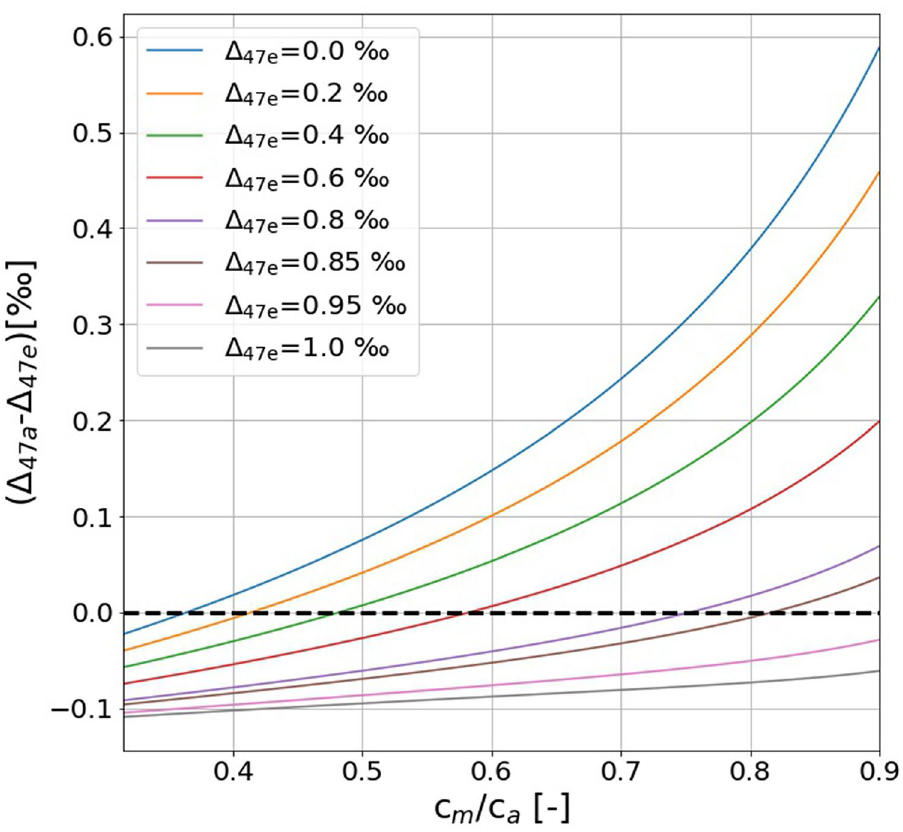
Figure 3. Difference between Δ 47 of out- and inflowing CO 2 as function of the fraction of CO 2 diffusing back to the atmosphere ( c m / c a ) calculated with the leaf cuvette model. The black dashed line shows the c m / c a ratio where the Δ 47 relative difference between the ingoing and outgoing CO 2 becomes zero for the corresponding Δ 47 of CO 2 entering the